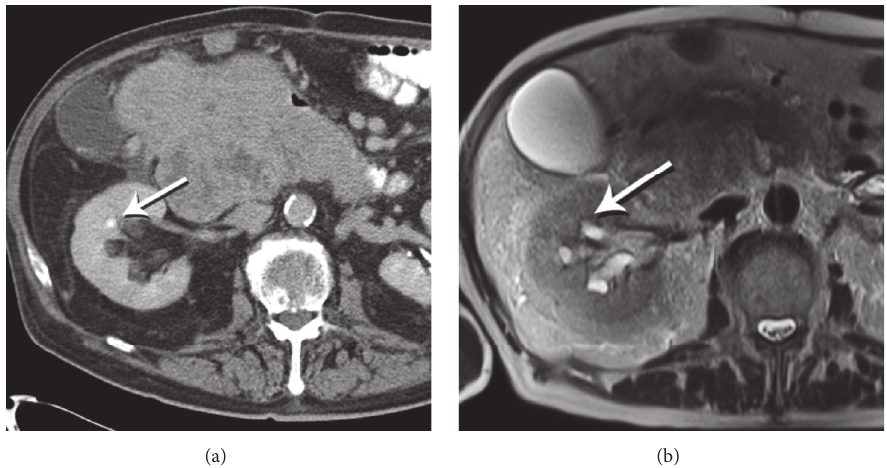
Figure2:StonevisibleonCT,butnotonMR.(a)Contrast-enhancedCTperformedfortumorstagingrevealsastoneinarightrenalinterpolar calyx (arrow). (b) Axial HASTE MRI image fails to detect the stone in the same calyx (arrow).